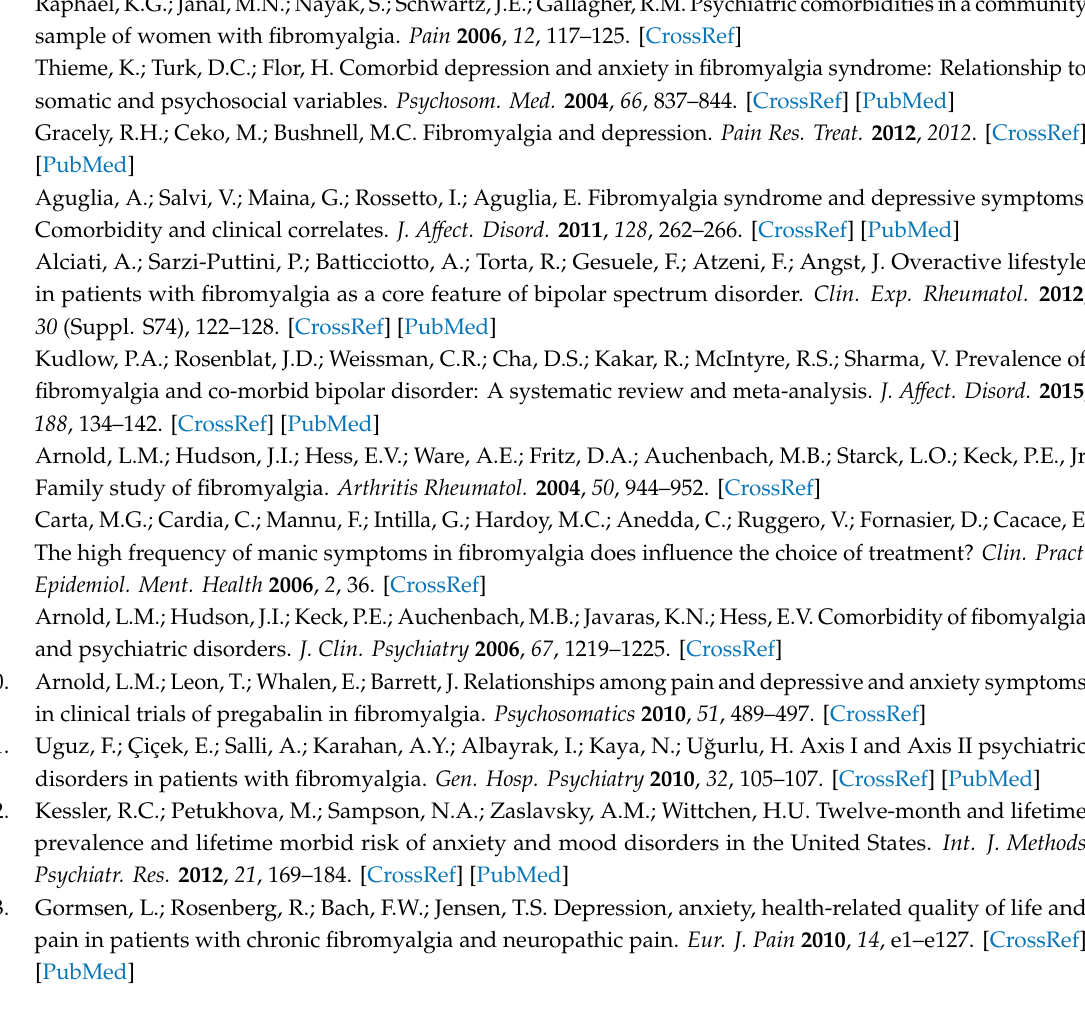
Table S1. Comparison between FM patients with and without comorbid threshold and subthreshold BD /